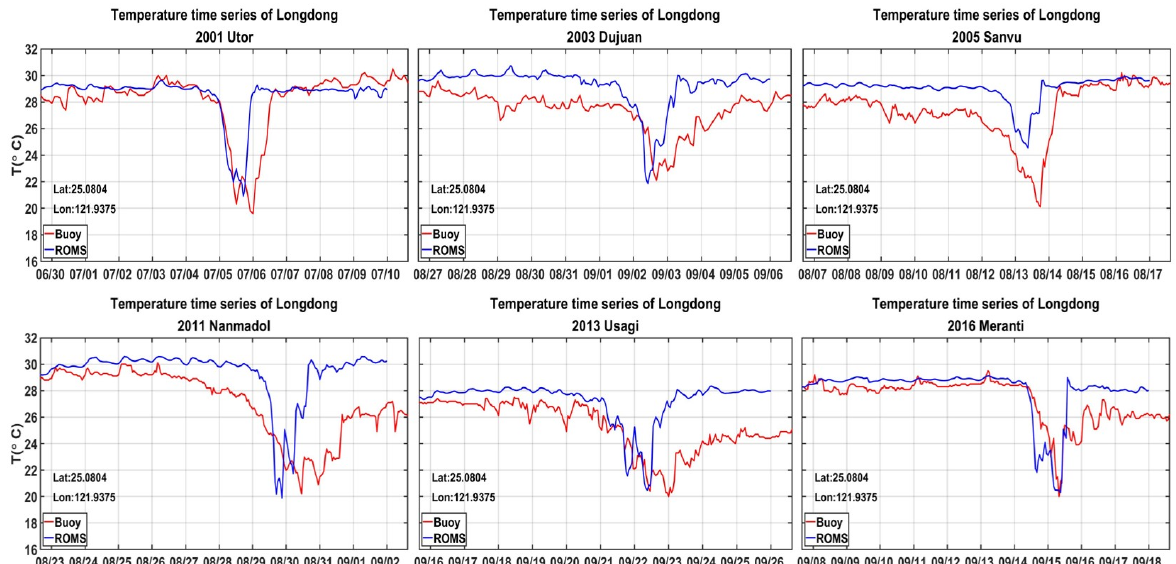
Figure 5. Same as Figure 4 but for comparison of TICWs derived from observations (red lines) and model simulations with tidal forcing as inputs (blue lines).